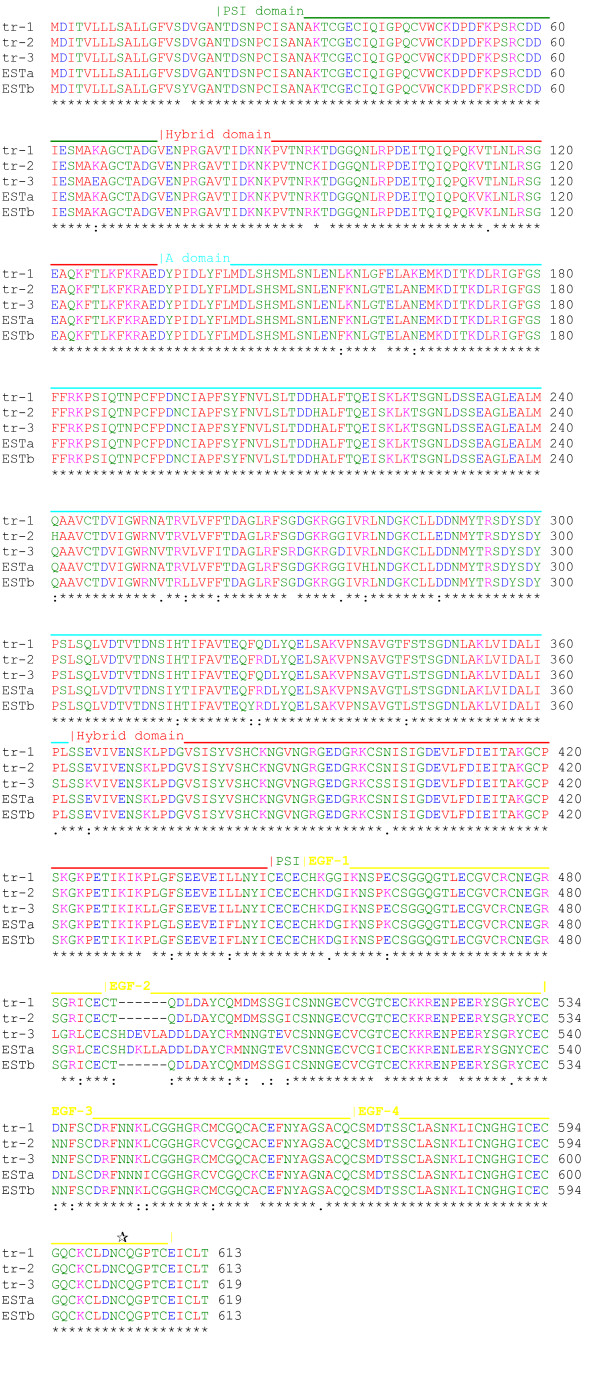
Alignment of zebrafish truncated β1 sequences. The alignment was performed using ClustalW. Protein domains are annotated: PSI, plexin/semaphorin/integrin; EGF, epidermal growth factor. Yellow bar indicates the position of a putative flexible linker region in EGF-2 [15]. Domain boundaries in the EGF repeats are as predicted by Takagi et al. [58]. Based on this prediction, the truncated β1 sequences contain four additional residues after the end of EGF-4. The position of an additional cysteine residue in EGF-4 (not seen in other β subunits) is indicated by tial. Sequence identities are indicated by *, conservative substitutions by :, semi-conservative substitutions by.